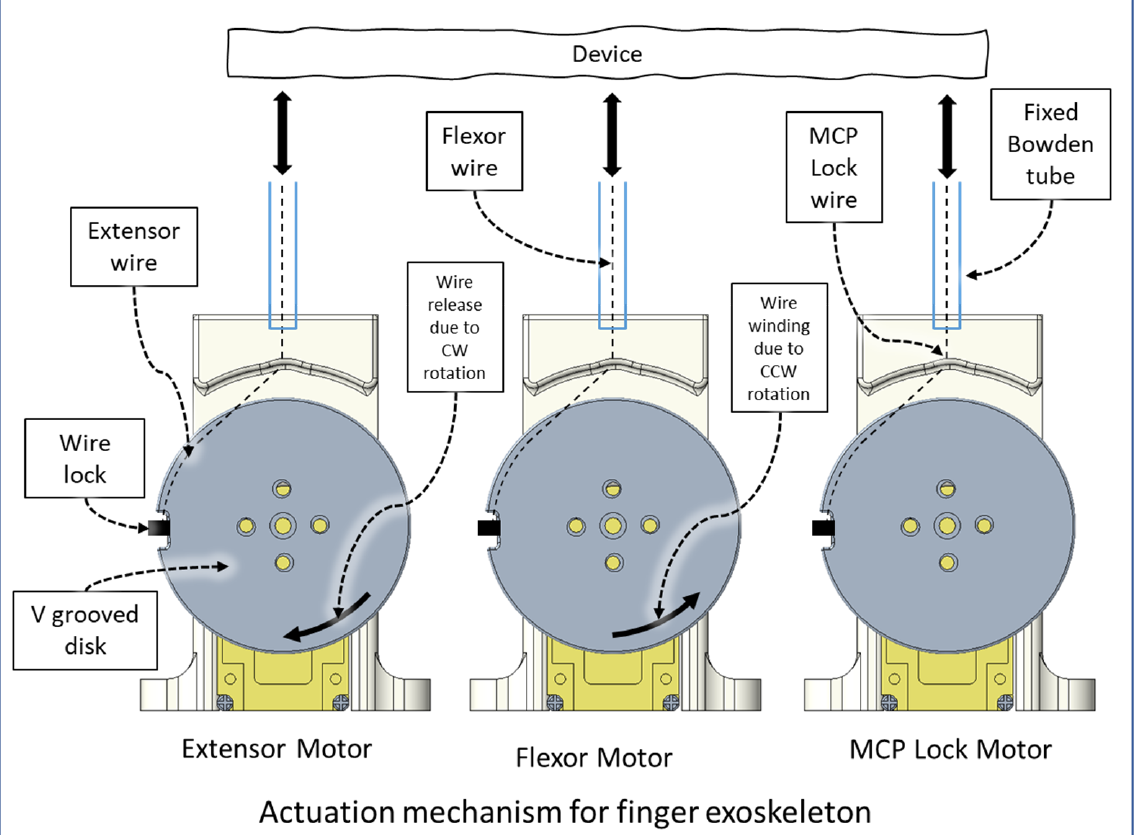
Figure 9. Actuation mechanism.